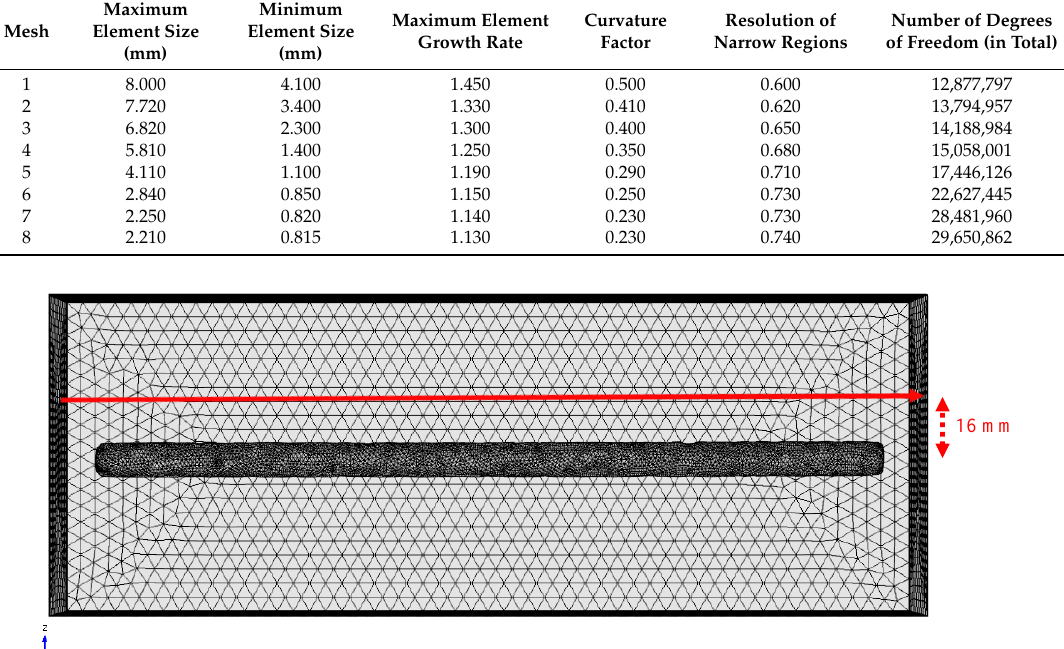
Table 5. Different mesh specifications of box, with the fixed mesh specifications of rebar (rebar mesh # 8).